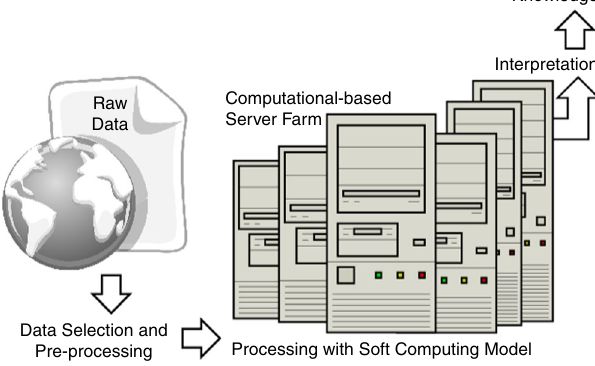
Figure 3. Proposed model